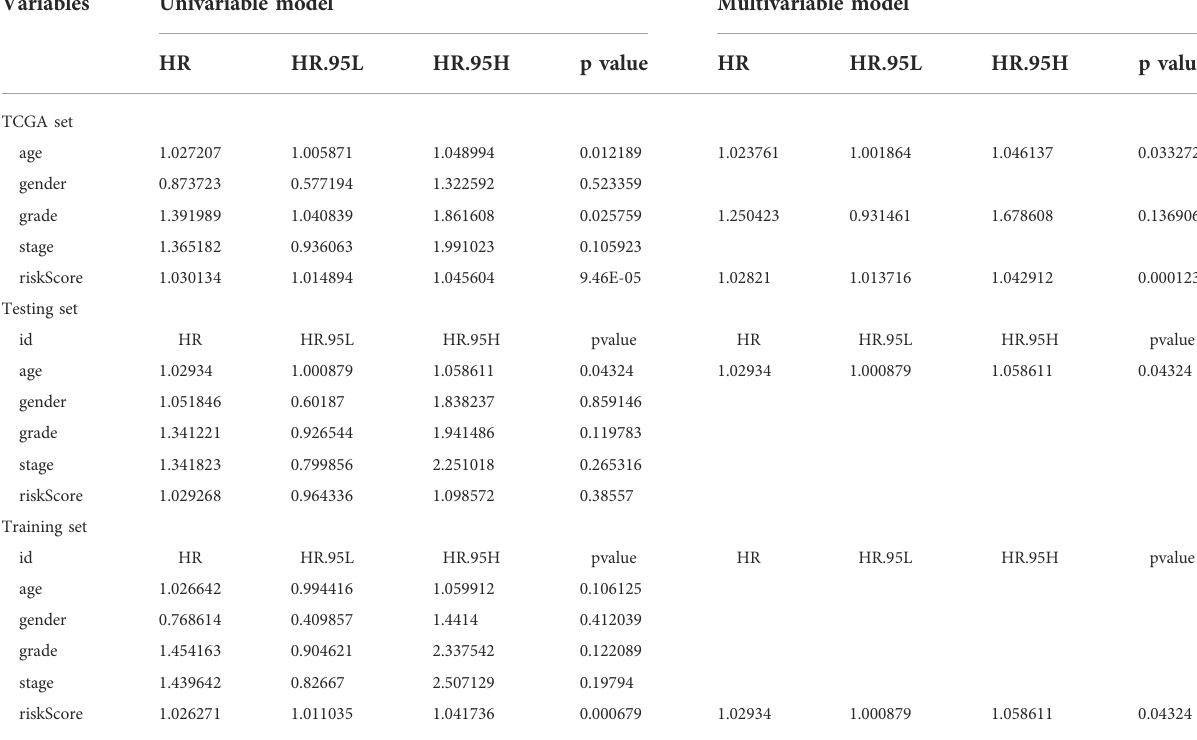
TABLE 1 Univariate and Multivariate Cox regression analysis of the GILncSig and clinical features for the independent prognostic signi fi cance in different patient datasets.